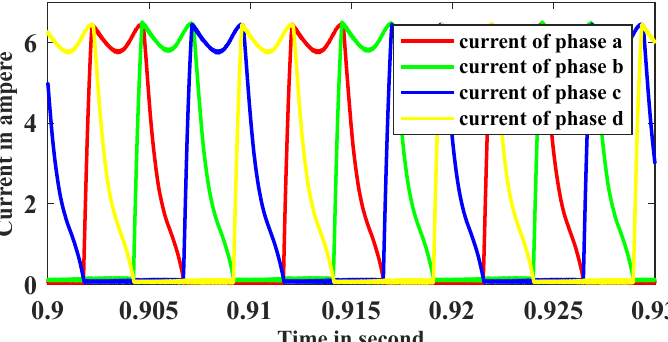
Figure 7. Stator current vs. time of 4-phase SRM drive using FO-PI controller and MWAO optimization algorithm.